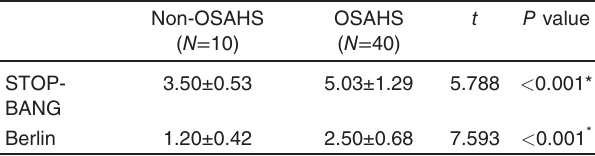
Table 2 Screening questionnaires of the studied patients